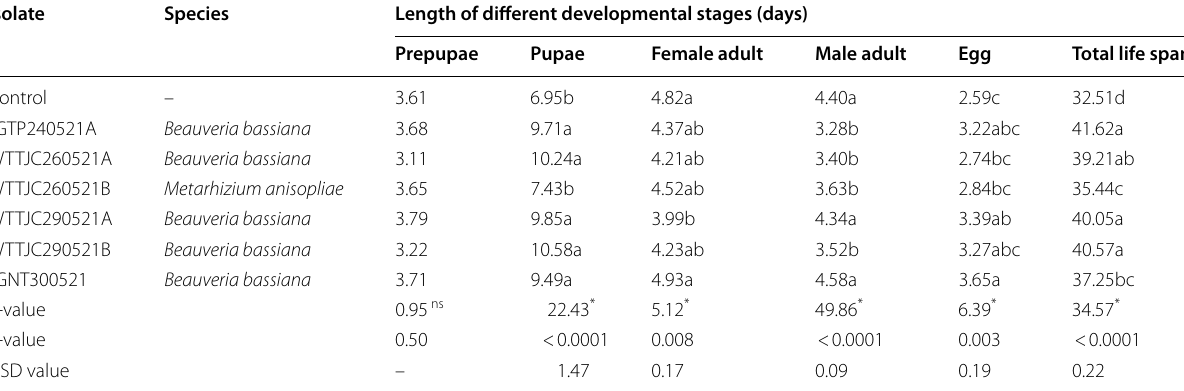
ns not significantly different * significantly different; values within a column followed by the same letters were not significantly different at P < 0.05 according to = = Tukey’s HSD test